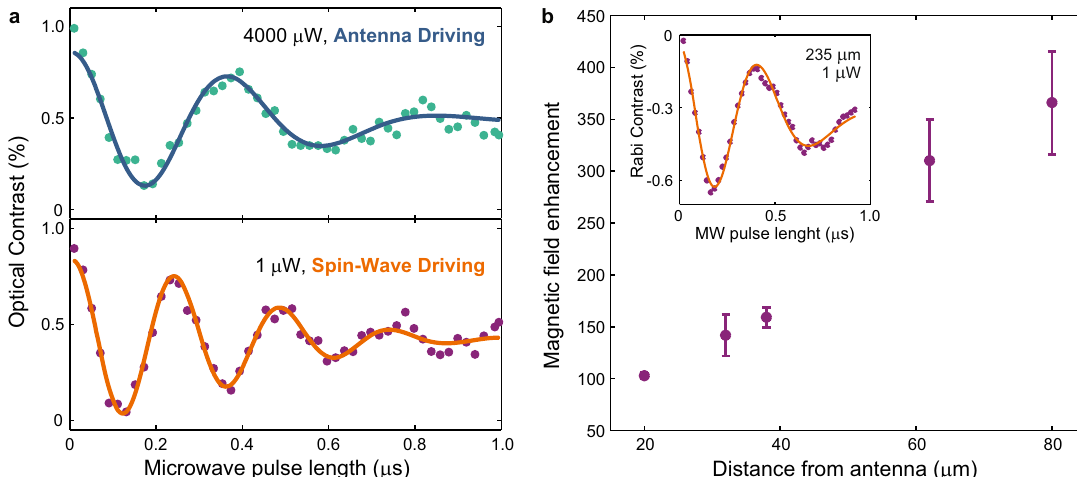
Fig. 4 Comparison of antenna and spin wave mediated coherent driving. a , Rabi oscillations measured on NP-Q (20 μ m away from the MSL) at the same microwave driving frequency (2.862 GHz) but different external magnetic fi eld and microwave power. The top curve is measured in the antenna driving regime at 15 G and using 4 mW of microwave power. The curve at the bottom is collected in the pure SW driving regime at 145 G and using 1 μ W of microwave power. b , Microwave magnetic fi eld enhancement as a function of the ND ’ s distance from the antenna showing the effect of the long SWs damping lengths. The error bars re fl ect imprecisions in the determination of the Rabi frequencies. In the inset we show the Rabi signal obtained at high fi elds when the particle is ~235 μ m away from the antenna using 1 μ W of microwave (MW)